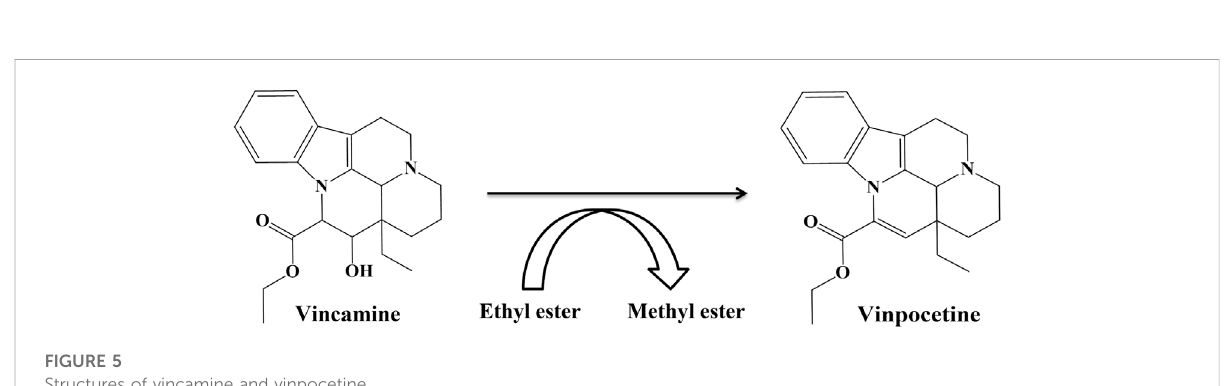
Structures of vincamine and